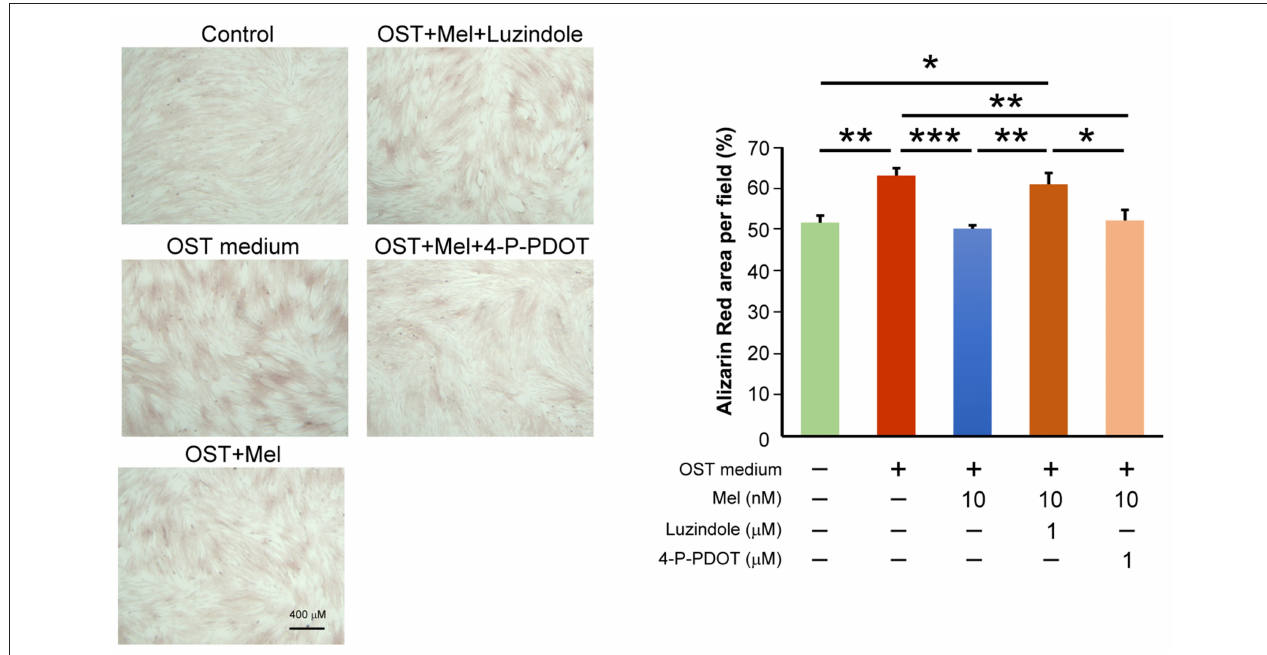
FIGURE 4 | The left panel depicts representative Alizarin red S staining of VICs with or without melatonin (10 µ mol/L); with or without Luzindole (1 µ mol/L); or with or without 4-P-PDOT (1 µ mol/L). The positively stained area (red color) was quantified using ImageJ. We quantified the stain-positive area ratio per field (three fields per sample) in the VICs (n = 8). The right panel presents the average data of the percentage of calcification area (n = 8). OST vs. OST + Mel 10 nM: P = 0.001. OST vs. negative control: P = 0.005. OST vs. OST + Mel 10nM + 4-P-PDOT 1 µ M: P = 0.008. OST + Mel 10nM vs. OST + Mel 10nM + Luzindole 1 µ M: P = 0.008. OST + Mel 10nM + Luzindole 1 µ M vs. negative control: P = 0.028. OST + Mel 10nM + Luzindole 1 µ M vs. OST + Mel 10nM + 4-P-PDOT 1 µ M: P = 0.043. OST, osteogenic medium; Mel, melatonin. * P < 0.05, ** P < 0.01, *** P <